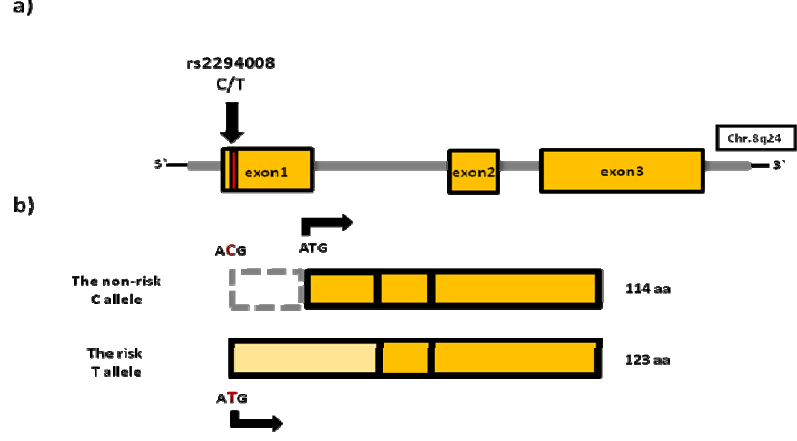
Figure 1. ( a ) PSCA locus and location of rs2294008; ( b ) Influence of rs2294008 on PSCA protein